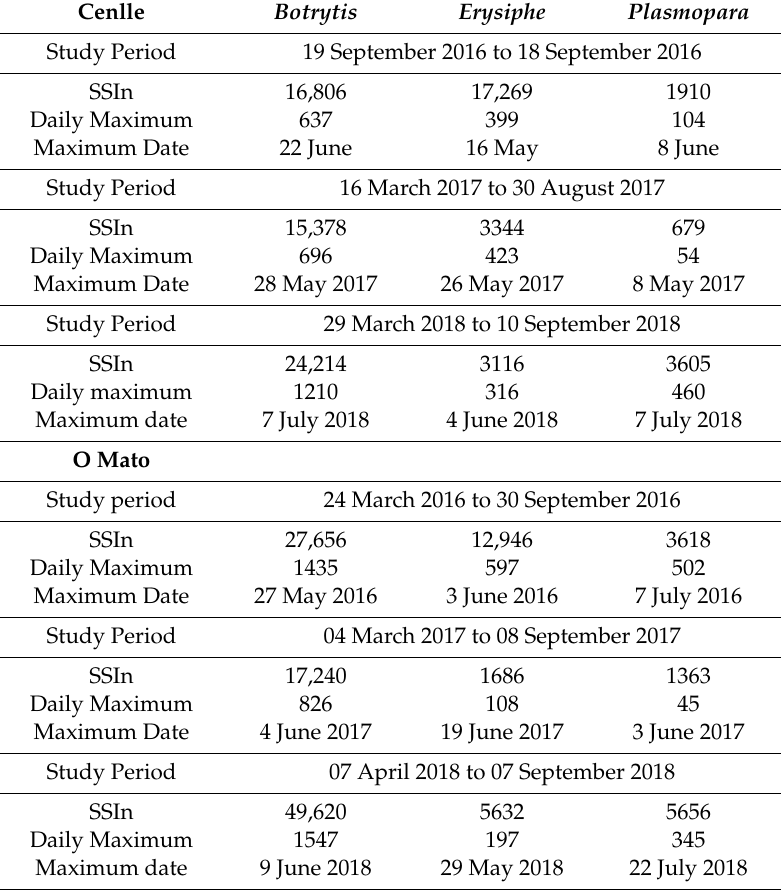
Table 3. SSIn data, daily maximum spore concentration and maximum date for Botrytis , Erysiphe , and Plasmopara in Ribeiro (Cenlle) and Ribeira Sacra (O Mato) DOs during the study period (spores / m 3 of